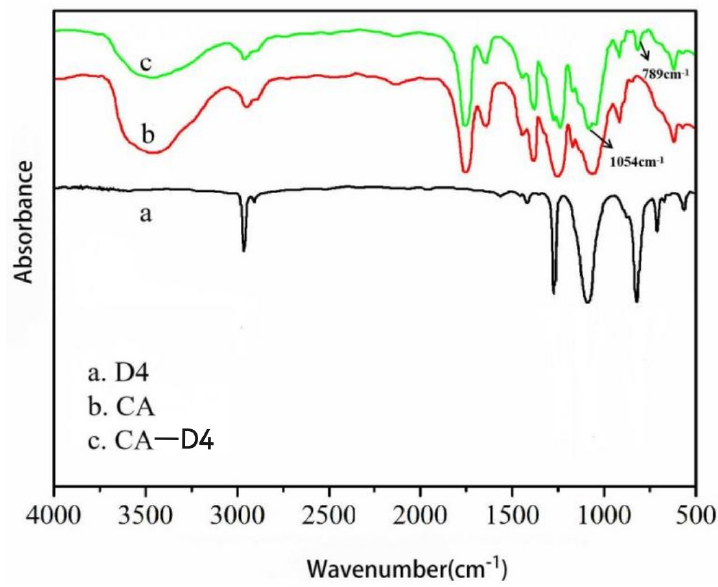
Figure 11. Infrared spectrum of CA fiber after grafting D4.